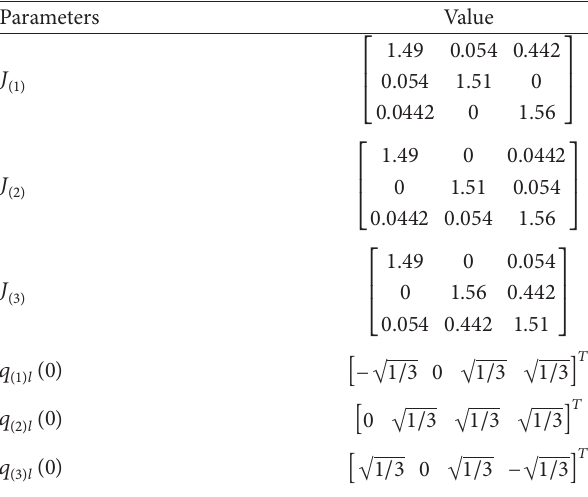
Table 2: Parameter simulation for cooperative spacecrafts case. Parameters